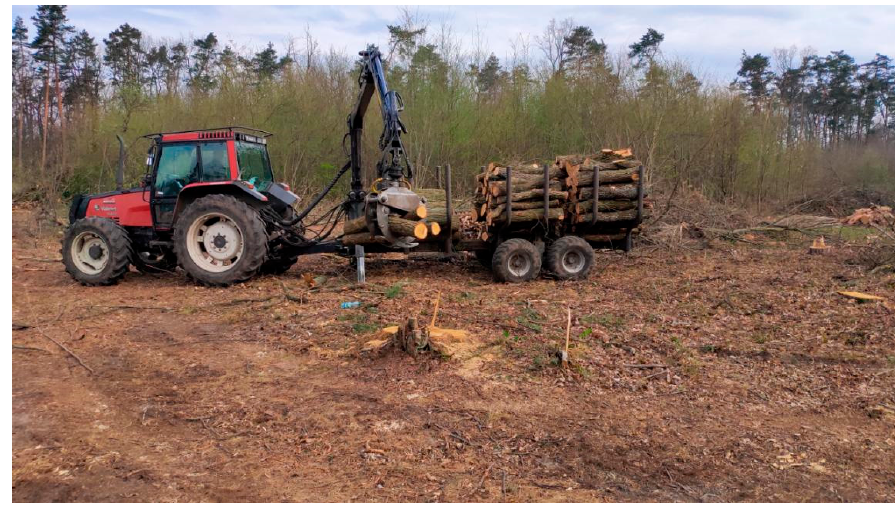
Figure 2. Valmet 6300 farm tractor, Palms 101 forestry trailer equipped with a Palms 670 crane. Table 1. Characteristics of the machines in the study